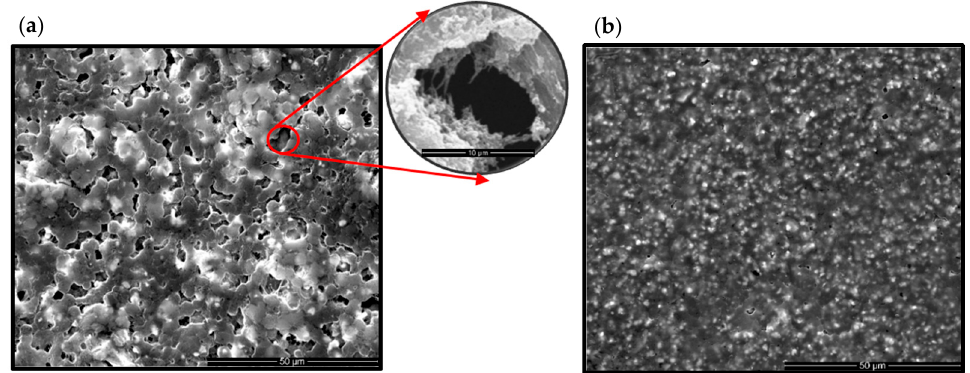
Figure 6. SEM images, ( a ) PVDF/ PZT/ CNTs (40:59.75:0.25), zoomed in picture shows CNTs. ( b ) PVDF/ CCTO (40:60), showing a homogenous distribution of powder with less agglomeration.